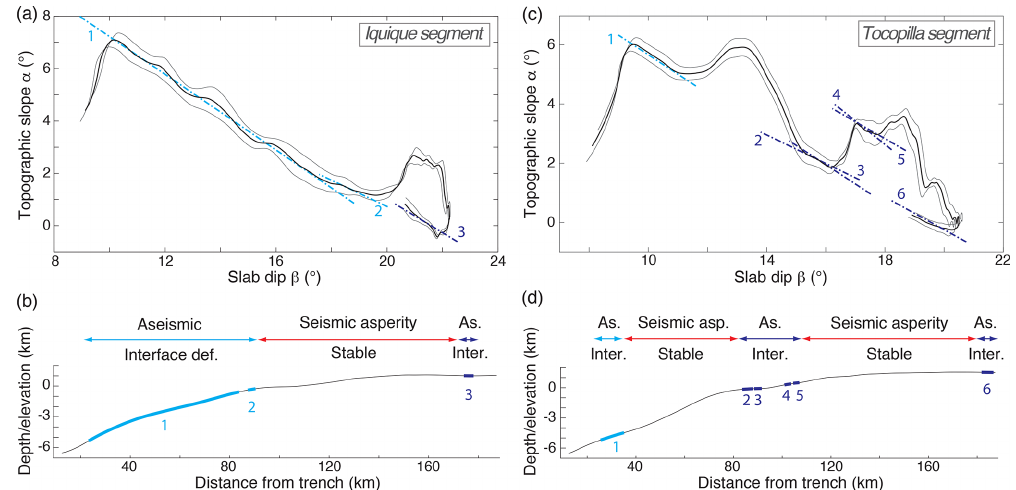
Figure 3. (a) Topographic slope ( α ) versus slab dip ( β ) for a swath profile along the Iquique segment (locations on Fig. 1b). Gray: swath plus or minus standard deviation. Segments at critical state, according to inversion, are shown in blue. For every segment, the difference between the effective internal and basal friction is lower than 1 (properties of each segment are provided in Table 1 in the Supplement). They are thus interpreted as regions of favorable plate interface deformation, shown in light blue when probably erosive and dark blue for probable underplating. Depth and distance to the trench can be viewed in Fig. S5 in the Supplement. (b) Relocation of the critical segments on the swath profile. (c) Topographic slope ( α ) versus slab dip ( β ) and (d) relocation of the critical segments for a swath profile along the Tocopilla